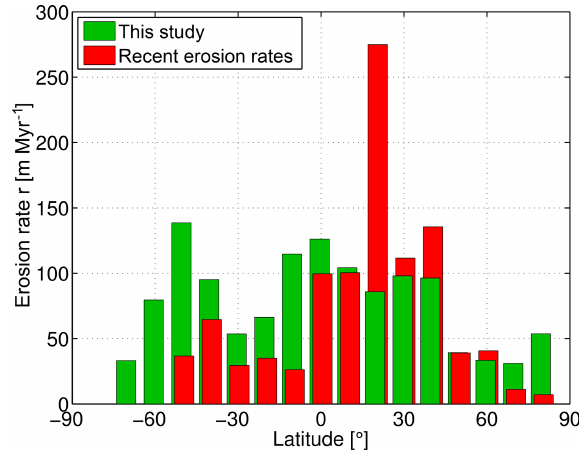
sive provinces) with 95 % confidence limits of 52 and 116 m Myr − 1 (see Appendix A). Our result is almost 40 % higher than the mean Pleistocene (2.58–0.01 Ma) erosion rates of r = 56 m Myr − 1 obtained from preserved sediments (Wilkinson and McElroy, 2007). The latter value is even close to our lower 95 % confidence limit, and all known val- ues for earlier periods of Earth’s history are even lower. This result already suggests that erosion rates in the past might be much higher than those obtained from preserved sediments.